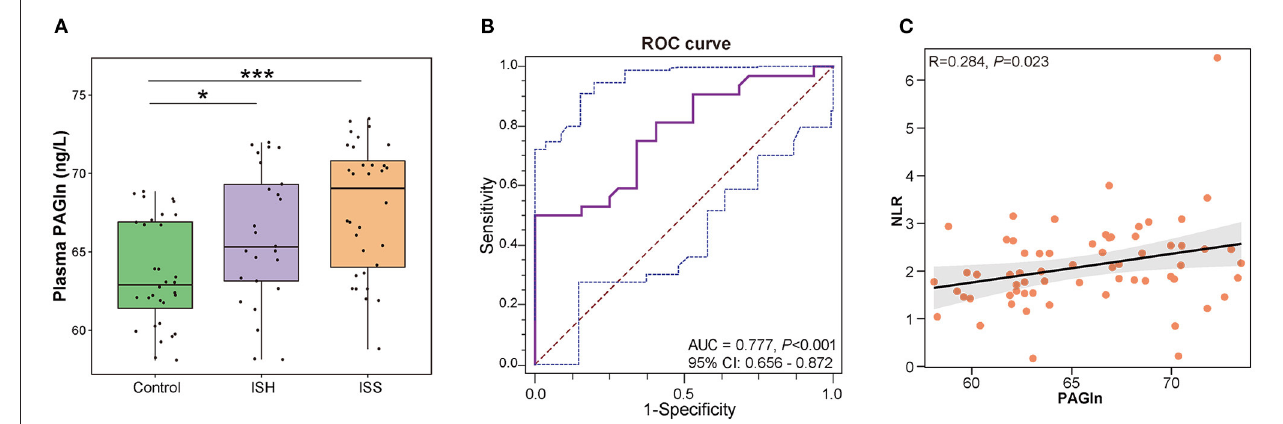
FIGURE 5 | Elevated plasma PAGln levels in CAD patients with in-stent patency, hyperplasia, and stenosis. (A) Higher plasma PAGln levels in the ISH and ISS groups than the controls. Control vs . ISH, P = 0.028; ISH vs . ISS, P = 0.128; *, P < 0.05; ***, P < 0.001; Wilcoxon rank-sum test; n = 32 for the control group, n = 25 for the ISH group, n = 32 for the ISS group. (B) ROC curve for plasma PAGln (AUC = 0.777, P < 0.001, 95% CI: 0.656–0.872). (C) Positive correlation between the plasma PAGln level and NLR (R = 0.284, P =